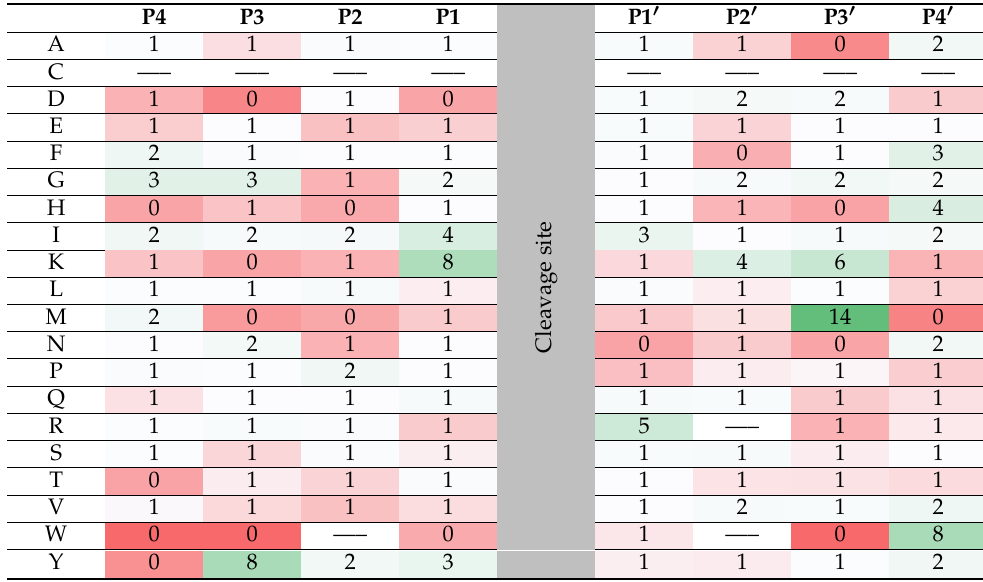
Table 1. Heat map (red = low, green = elevated) showing the relative frequency of amino acids near cleavage sites of bovine beta-casein digested with enzyme extracts from distorted Fusarium -damaged kernels (FDK-D) relative to clean (uninfected) seed. Elevated numbers mean the specified amino acid occurred at a position in more peptides in the FDK-D digest than base seed digest, i.e., lysine was eight times more often at p1 in the FDK-D